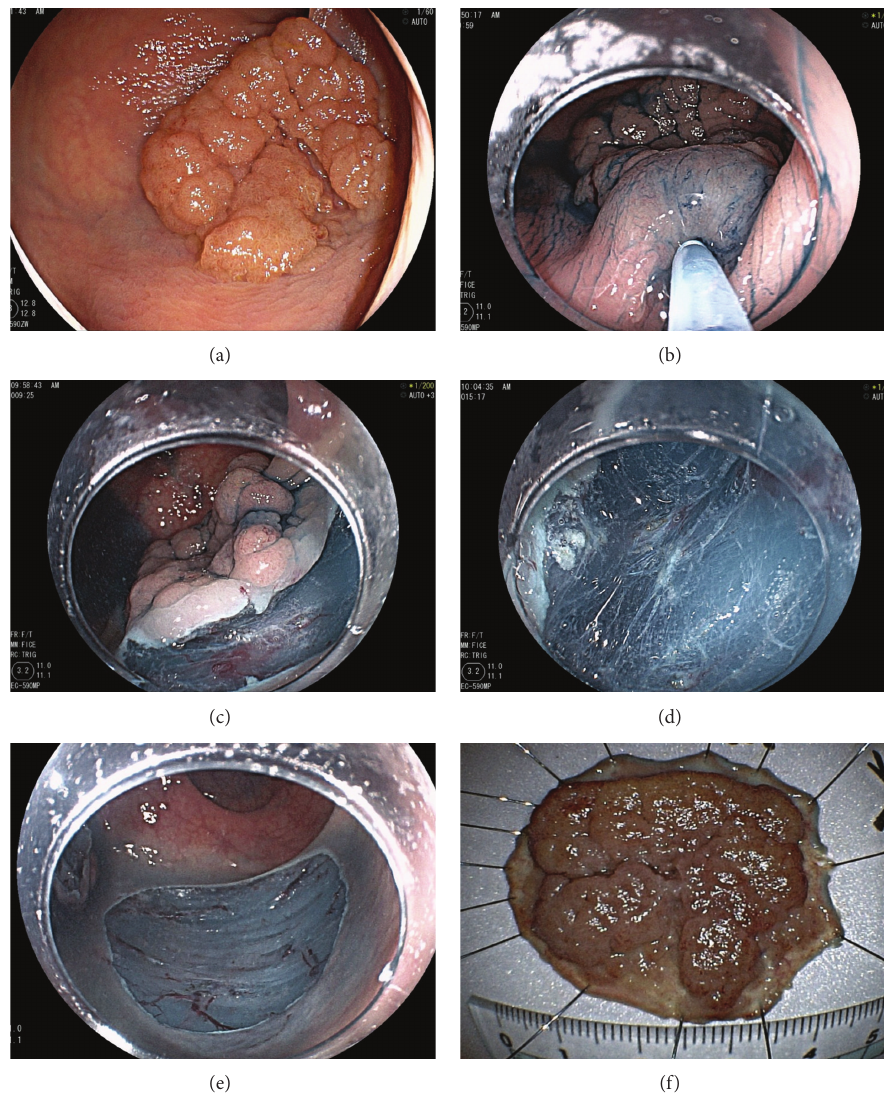
Figure 1: Strategy for endoscopic submucosal dissection. (a) 0-IIa tumor, 30mm, located in the rectum. First, the tumor and its margin were observed carefully. (b) Injection was performed at the anal (distal) side of the tumor. (c) A partial circumferential mucosal incision was made. (d) Submucosal dissection was performed. (e) The tumor was resected en bloc . (f) Resected specimen. Histopathological diagnosis: intramucosal cancer, margin: